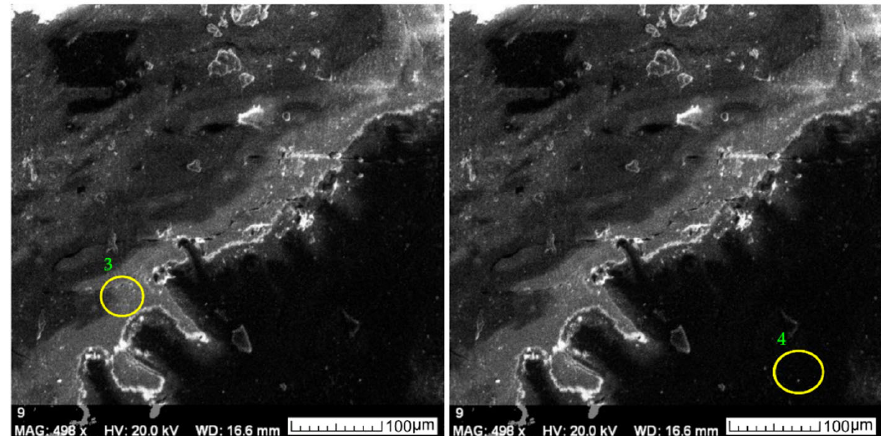
Figure 8. EDX spectrum for the varnish sample, zone 3. Figure 9. EDX spectrum for the varnish sample, zone 4.